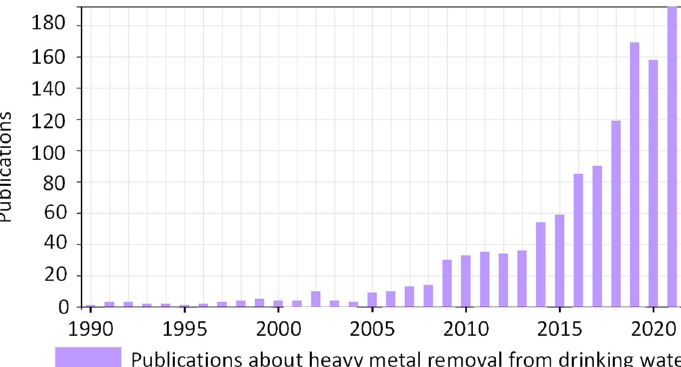
Figure 10. Evolution of the number of publications about heavy metal removal from drinking water from 1990 to 2021. Source: Web of Science. Table 3. Classification of the most relevant works of the last ten years about heavy metal removal from drinking water, identifying the target heavy metal, and the type of